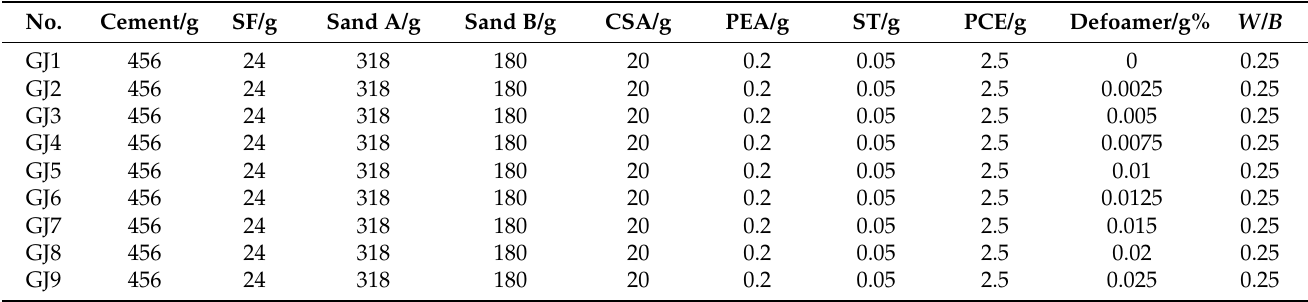
Table 2. Mix proportions of the